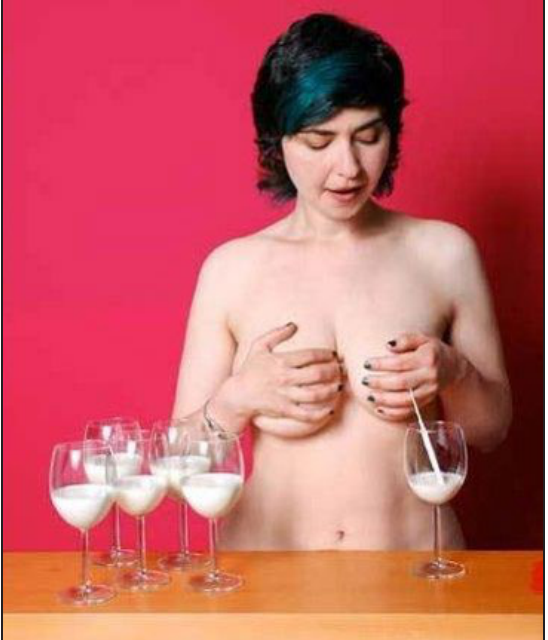
Figure 3: Jess Dobkin, publicity photograph for Lactation Station Breastmilk